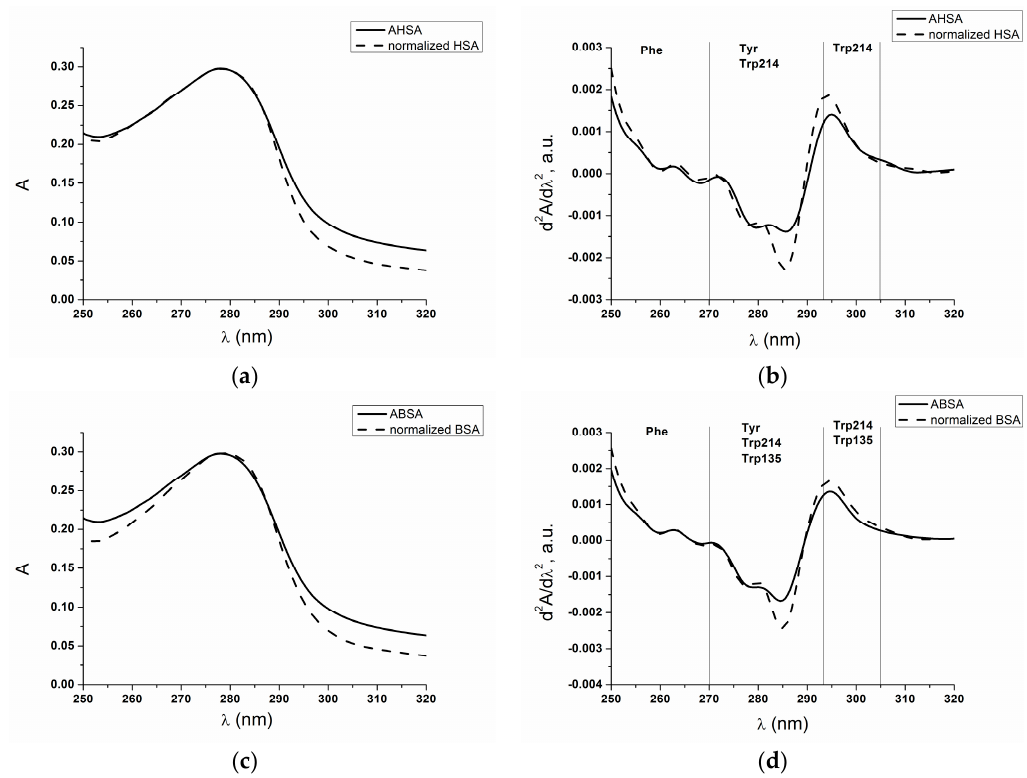
Figure 1. Normalized zero-order ( a , c ) and second derivative absorption spectra ( b , d ) of non-modified and aged human serum albumin (HSA and AHSA, respectively) and bovine serum albumin (BSA, and ABSA, respectively) ; protein concentration was 5 × 10 − 6 mol/dm 3 .